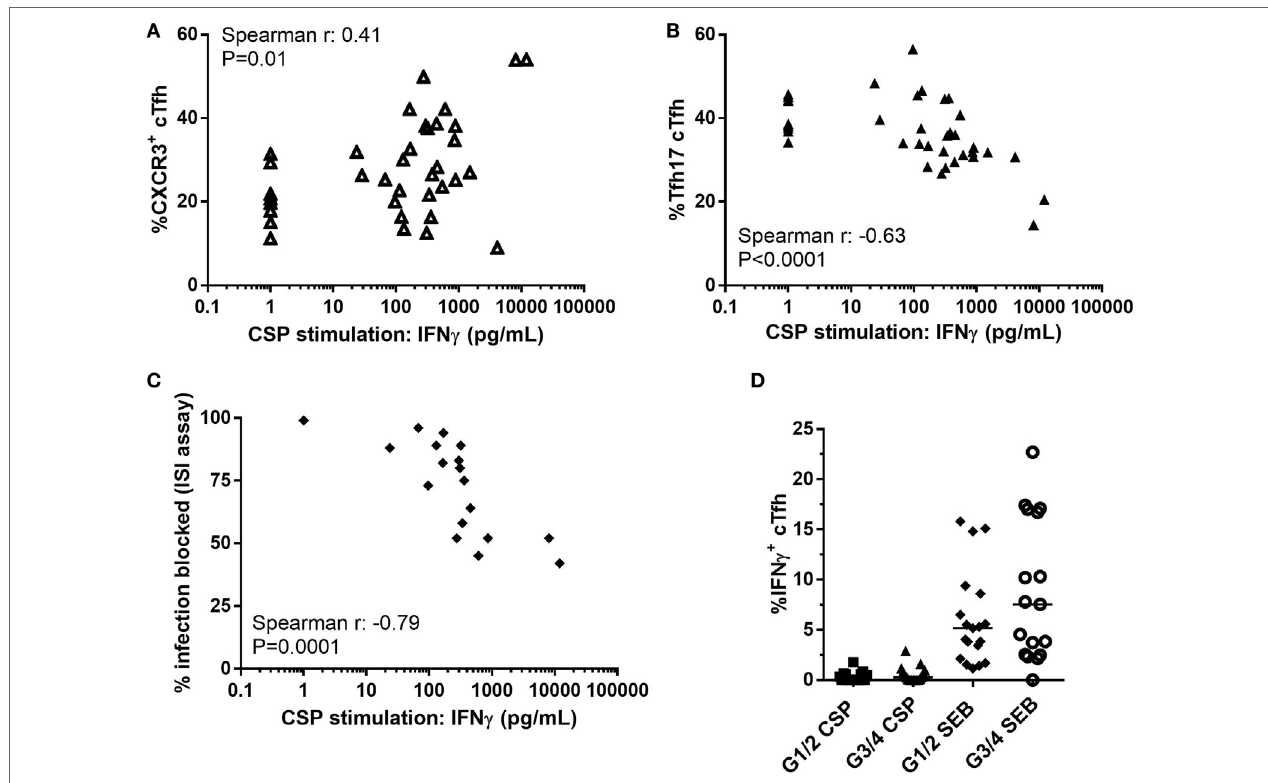
FigUre 6 | Association between Th1-biased cytokine responses and suppressed humoral immunity. Relationship between concentration of IFN γ in supernatant of PBMCs stimulated with CSP in co-administration trial (G1–4, R, and R + V combined) and: (a) Proportion of CXCR3 + cTfh (Spearman r : 0.41, P = 0.01); (B) Proportion of cTfh17 (CXCR3 + CCR6 − ) within cTfh (Spearman r : -0.63, P < 0.0001); (c) Percentage of infection blocked in the ISI assay (Spearman r : -0.79, P = 0.0001). (D) Proportion of IFN γ + cTfh after stimulation with CSP or SEB, Mann–Whitney analyses between G1/2 (R) and G3/4 (R + V) P = 0.14 and P = 0.26 for CSP and SEB stimulations, respectively. Abbreviations: R G1/2, RTS,S/AS01B vaccinated; R + V G3/4, RTS,S/AS01B and viral-vectored vaccines co-administered; R2V, RTS,S/AS01B and viral-vectored vaccines at a 2-week stagger; A, ChAd63 ME-TRAP; M, MVA ME-TRAP; R, 50 µg third dose of RTS,S/AS01B; r, 10 µg third dose of RTS,S/AS01B; CHMI, controlled human malaria infection; C-1, day before CHMI; CSP, circumsporozoite protein; cTfh, circulating T follicular helper cell; ISI, inhibition of sporozoite invasion; PBMCs, peripheral blood mononucleocytes; TRAP, thrombospondin-related adhesive protein; SEB, Staphylococcus enterotoxin